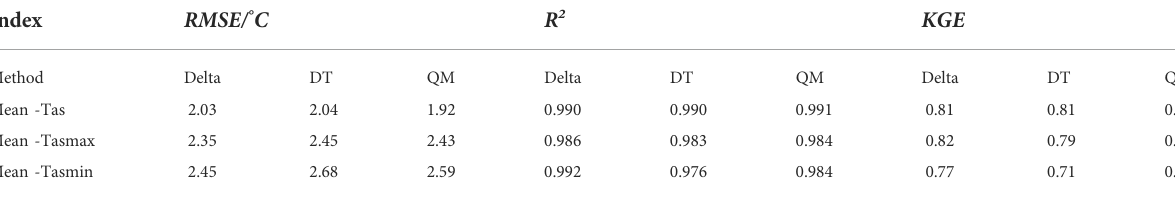
TABLE 3 Comparison of downscaling methods of the historical monthly Tas, Tasmax, and Tasmin of the